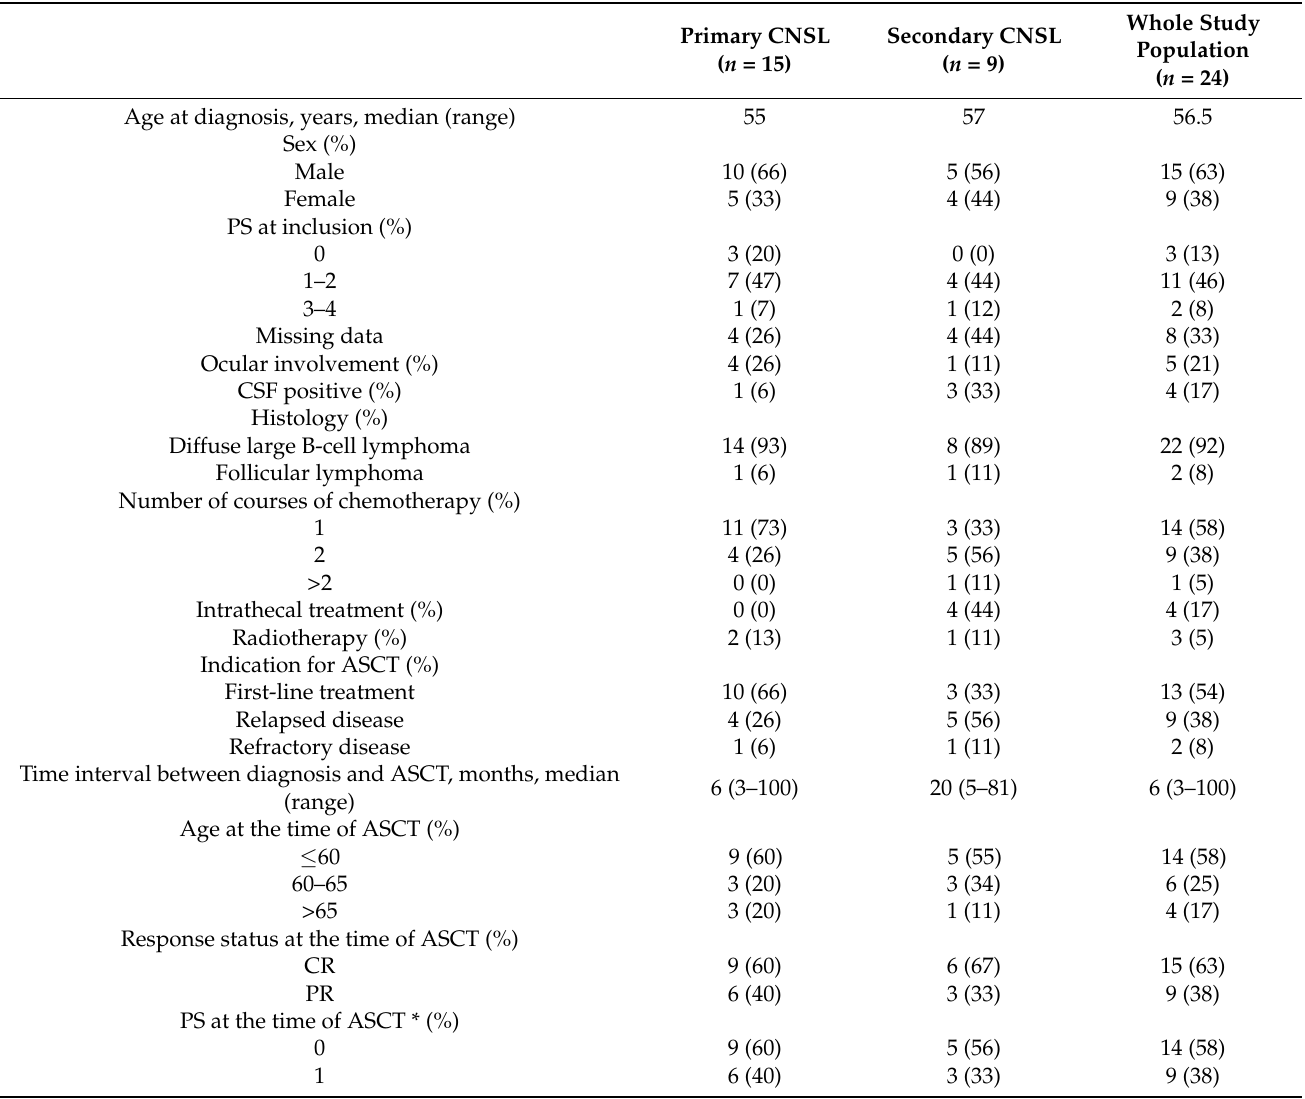
Table 1. Patient characteristics on inclusion.